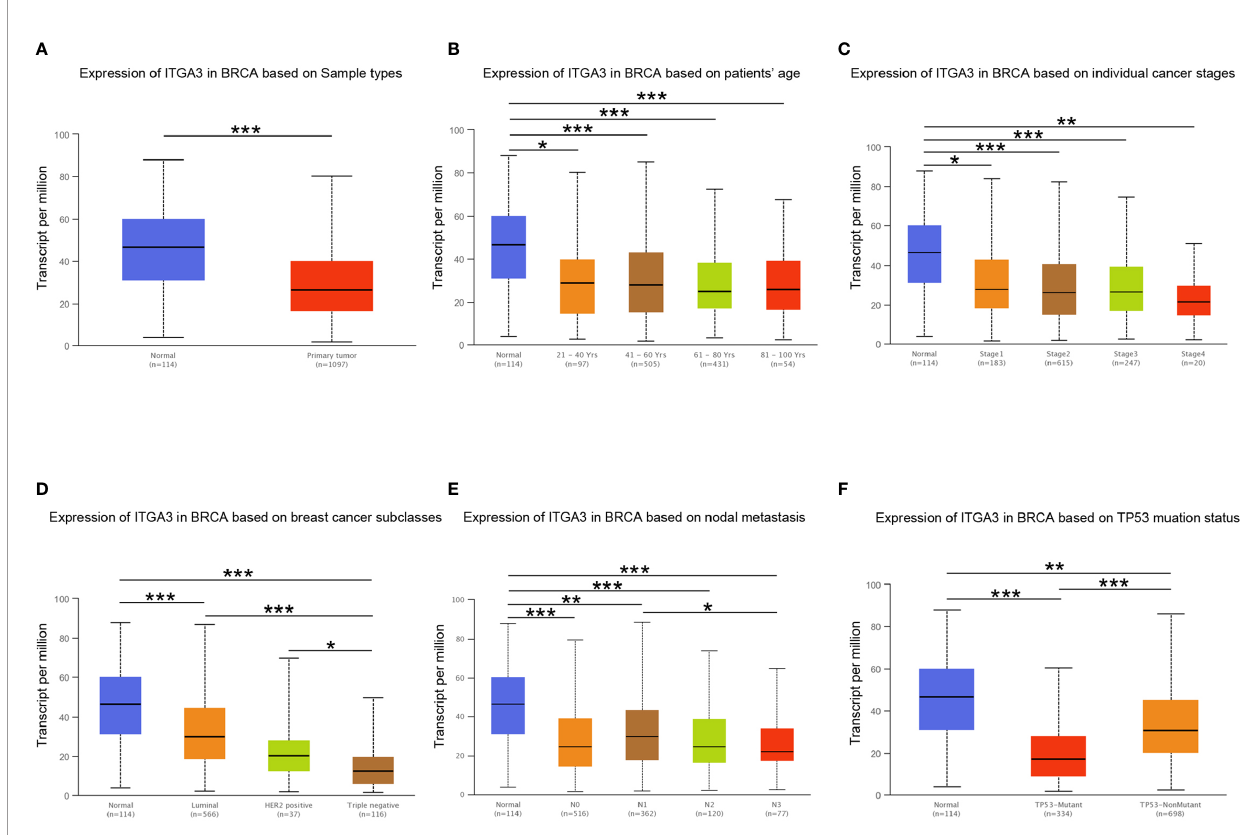
FIGURE 3 | ITGA3 transcription level in subgroups of patients with BRCA. (A) Boxplot of ITGA3 relative expression based on sample types. (B) Boxplot of ITGA3 relative expression based on patients ’ age. (C) Boxplot of ITGA3 relative expression based on cancer stages. (D) Boxplot of ITGA3 relative expression based on breast cancer subclasses. (E) Boxplot of ITGA3 relative expression based on nodal metastasis. (F) Boxplot of ITGA3 relative expression based on TP53 mutation status (The central mark is the median; the edges of the box are the 25th and 75th percentiles. *p < 0.05; **p < 0.01; ***p <